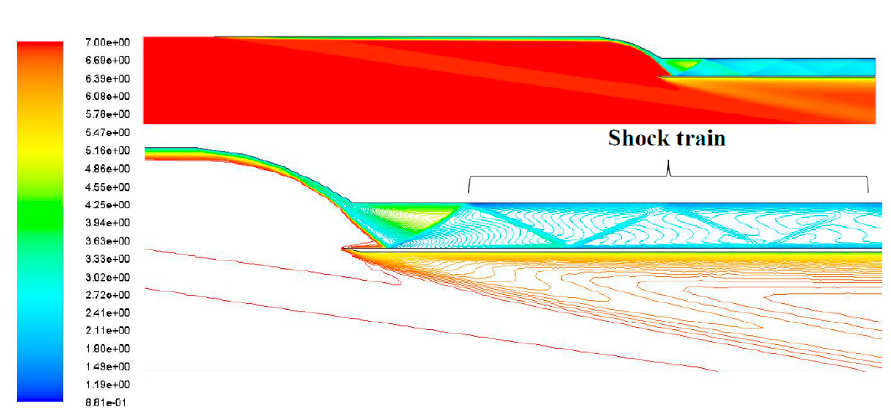
Figure 23. Mach contours of four ramp inlet at Mach 7.